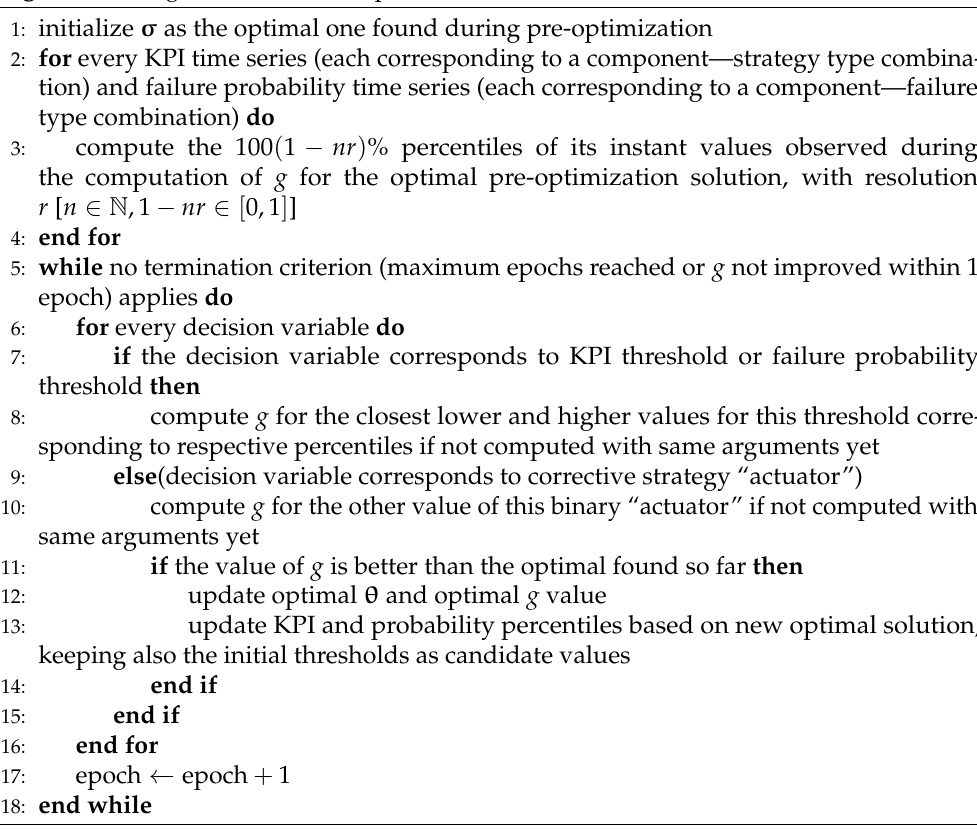
Algorithm 2 Algorithm for main optimization for decision variables